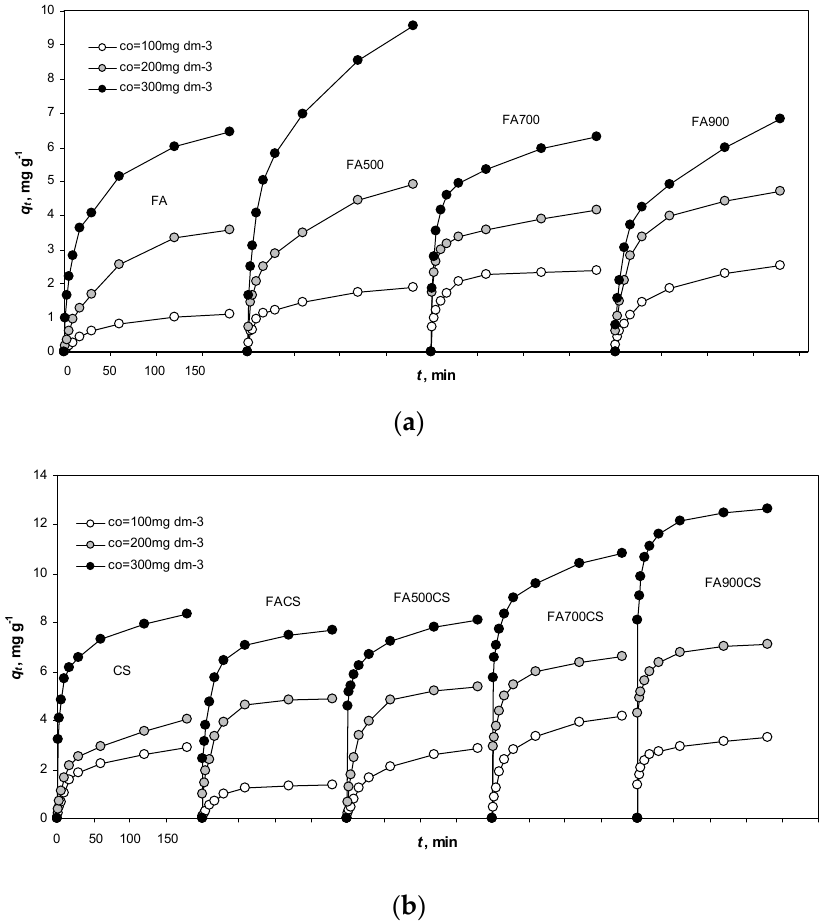
Figure 9. As(V) adsorption kinetics at pH = 6 for the studied adsorbents at various initial concentrations: fly ash ( a ); chitosan and chitosan modified fly ash ( b ). The scale bar on the t axis is drawn only for the first three curves (FA group in the upper plot and CS group in the lower plot). This scale bar is valid for the next adsorbents when shifted against the t axis to meet a = 0 point for any curve (it means that all curves start from zero concentration). The error bars are practically covered by the labels of the experimental points.